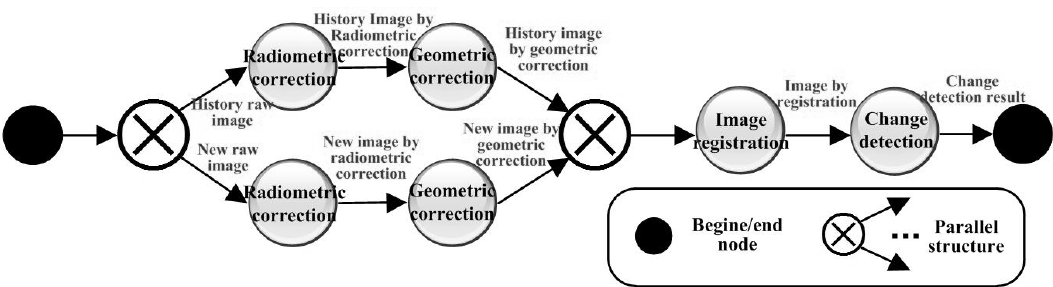
Figure 14. GISC of change detection.